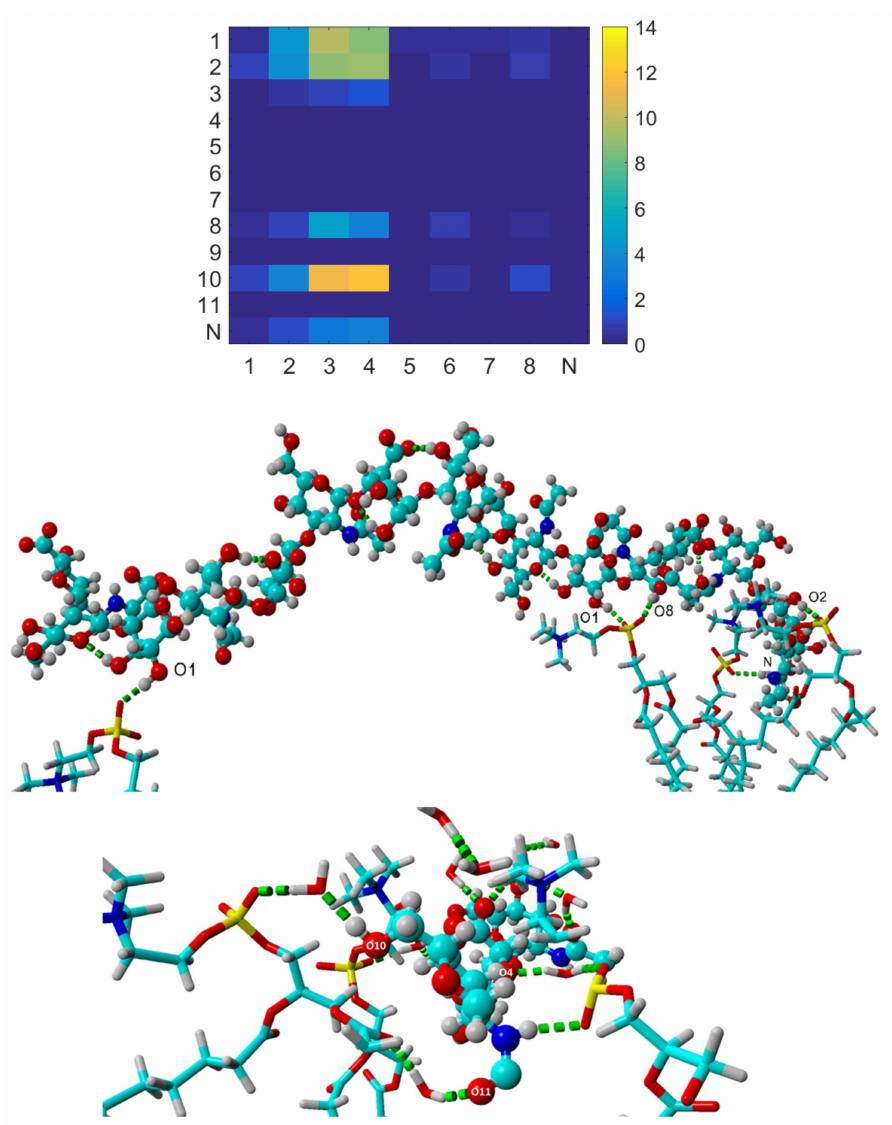
Figure 2. Top : Map of number of HA–DPPC hydrogen bonds between different atom classes in HA shown on the y-axis and DPPC shown on the x -axis in NaCl solution (see Figure 1). These are all the H-bonds found during the simulation after equilibration (the last 20 ns of the simulation). Copyright (2019), with permission from Elsevier [39]. Middle : A snapshot illustrating hydrogen bonds (green dashed lines) between HA (represented by ball-stick model) and DPPC (represented by stick model). Atoms are presented by colours as follows: oxygen—red, carbon—turquoise, hydrogen—white, phosphorus—yellow, nitrogen—dark blue. Bottom : A snapshot illustrating water- mediated hydrogen bonds (green dashed lines) between HA and DPPC. In the middle and bottom panels, parts of the HA and DPPC structures are hidden for better visualization of hydrogen bonds inside the